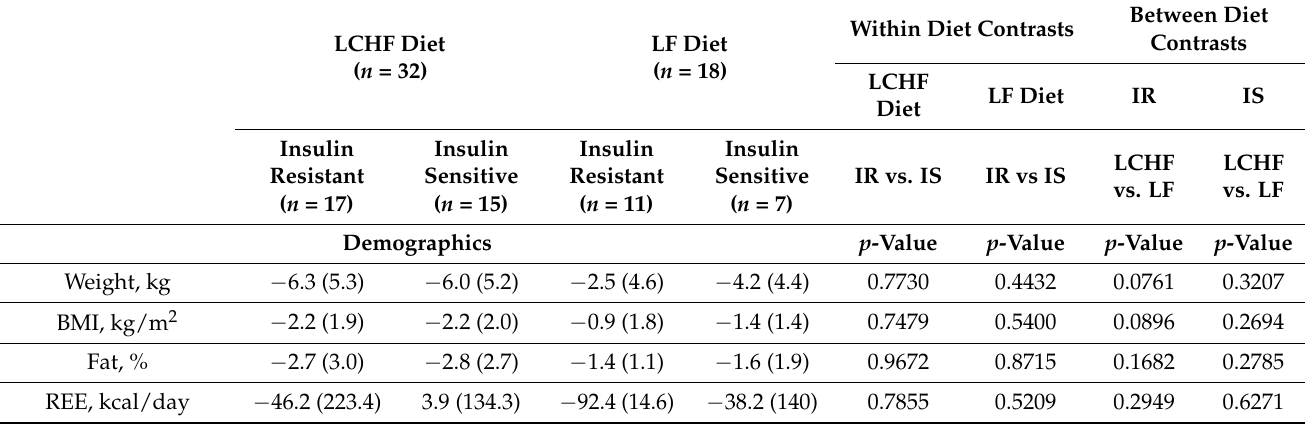
Figure 2. Age, sex, and race, adjusted comparison of change in body composition by diet group and insulin resistance phenotype. ( A ) Change in weight (total bar), fat mass (dark-filled segment), and lean mass (light-filled segment). ( B ) Change in android region fat mass (total bar), non-visceral android fat (dark filled segment) and visceral fat mass (light-filled segment). Changes in android regions and visceral fat were lower among insulin-resistant participants in the in the LF group versus the LCHF group ( p < 0.05). Table 3. Comparison of change between baseline and follow up by insulin sensitivity and diet group with pairwise contrast within and between diet